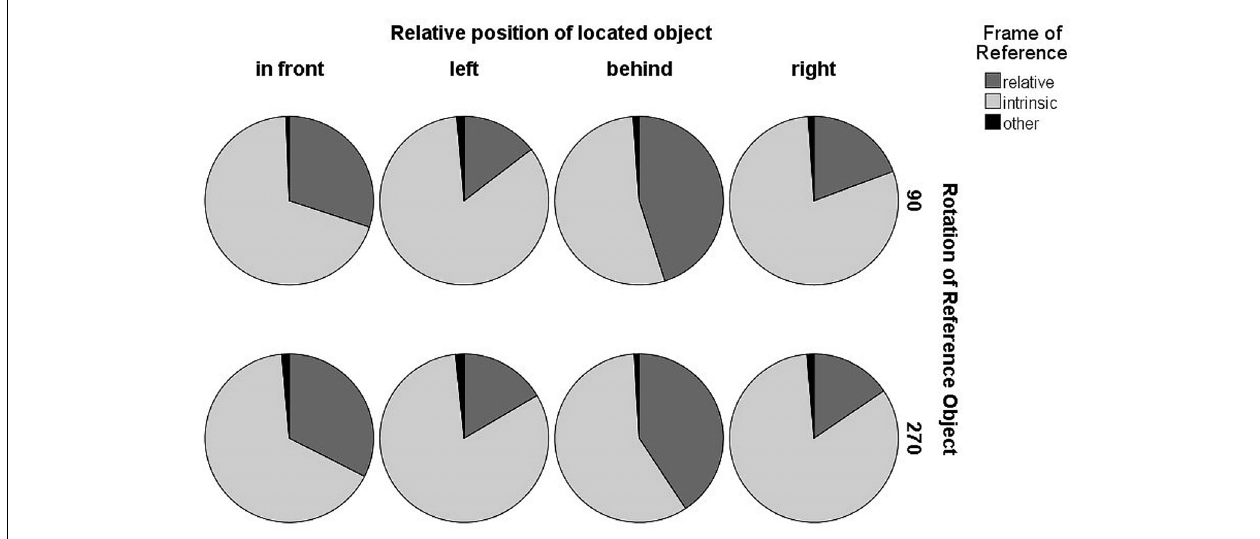
FIGURE 2 | FOR selection in the first